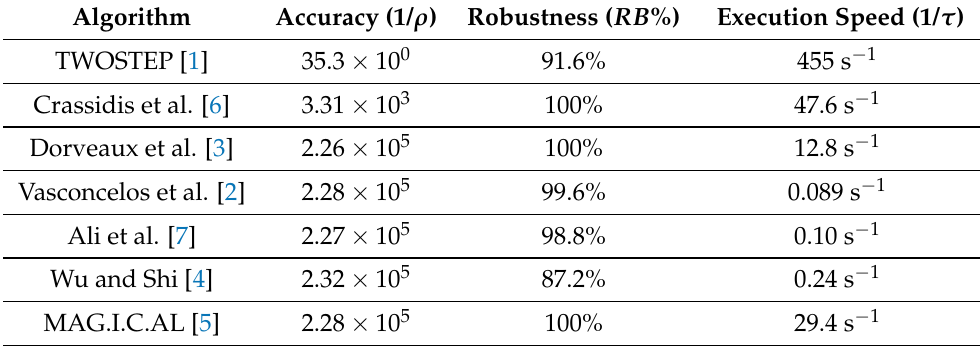
Table 2. Baseline evaluation of the presented algorithms.